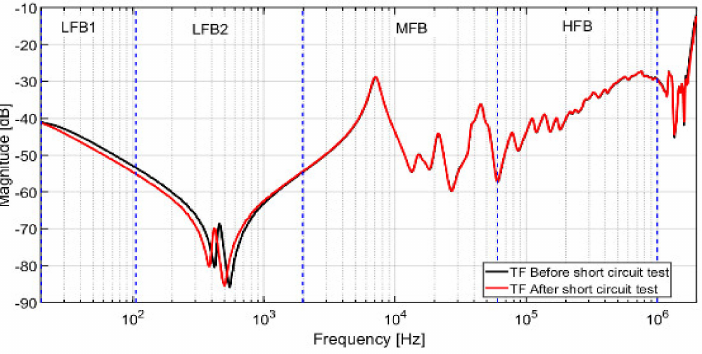
Figure 27. Frequency response of A-phase HV winding before and after the short circuit test